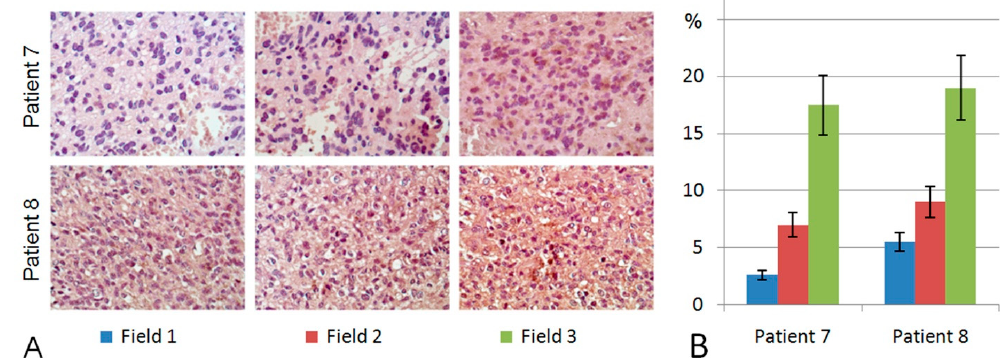
Figure 4. Intratumour heterogeneity of HPSE expression in glioblastoma. ( A ) Immunostaining of GBM tumours using anti-HPSE antibodies. Patients 7 and 8; Fields 1,2,3-observation fields of the histological preparation; counterstaining with Hematoxylin; magnification ×400; ( B ) Semi-quantitative analysis of anti-HPSE staining intensities in different observation fields. Bars represent the mean from